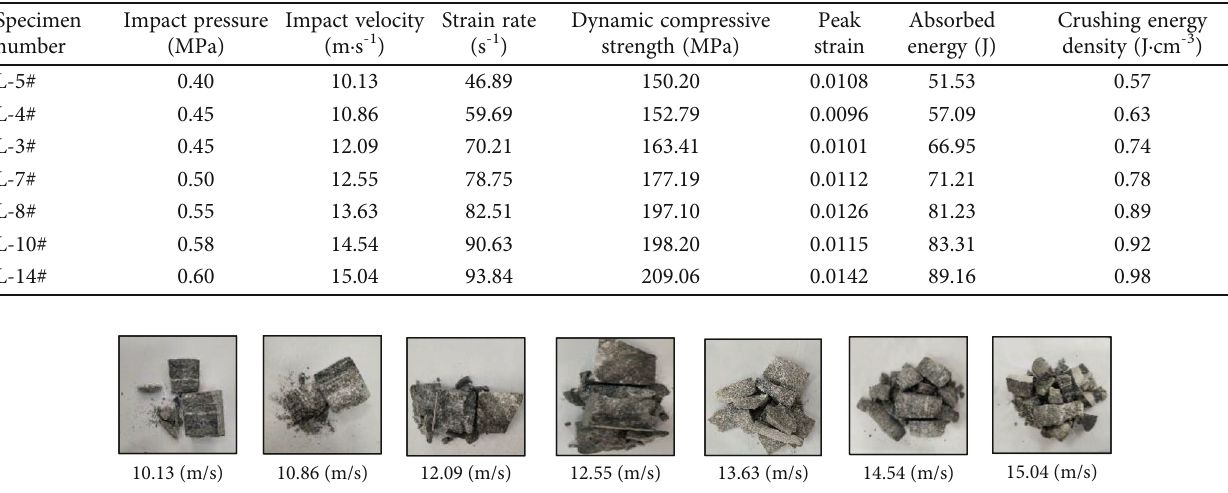
Figure 3: Damage pattern of pomegranate biotite schist at di ff erent impact